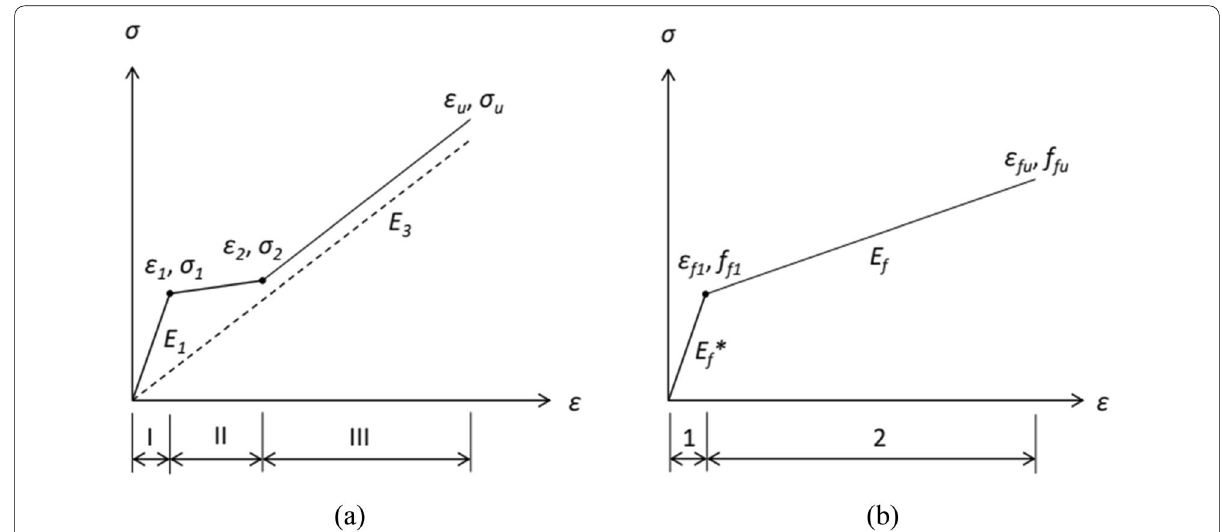
Fig. 1 Idealized stress–strain relationships of FRCM system in tension: a tri-linear relationship; b bi-linear